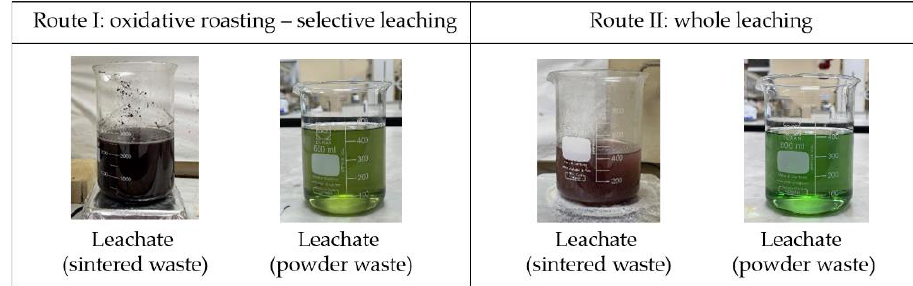
Figure 6. Leachates via route I and route II recycling, for sintered and powder NdFeB wastes.